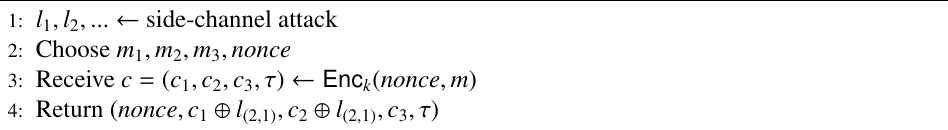
Algorithm 8 Attack against integrity. Forging a fresh and valid